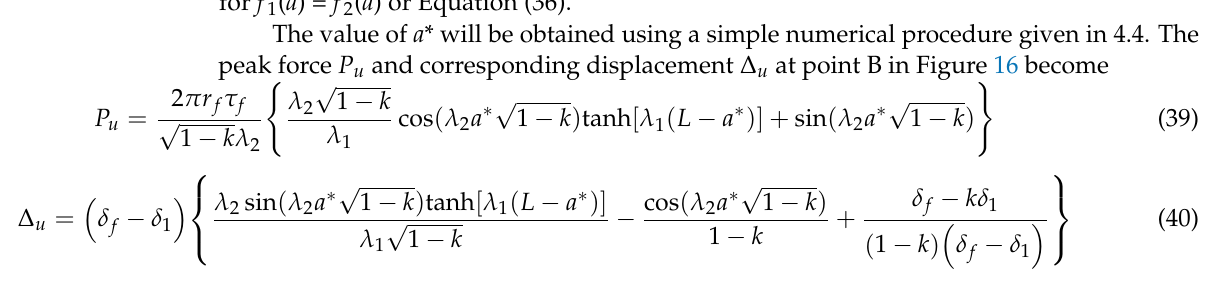
Figure 18. Function diagram for f 1 ( a ) and f 2 ( a ). The period T of f 2 ( a ) can be estimated considering the physical parameters of the materials used in the experiments. The magnitude (in the international standard unit system) of τ f , δ f − δ 1 , E f and r f is in the order of 10 6 Pa, 10 − 3 m, 10 11 Pa and 10 − 4 m, respectively, so λ 22 is in the order of 10 2 from Equation (21), that is, 1 < λ 2 < 10. Therefore, √ (cid:16) (cid:17) λ 2 T = π / 1 − k is higher than π /10 = 0.314 m, considering 0 < k < 1. The embedment length of steel fibres in this study is L = 0.04 m, which is much lower than T. This also applies to SFRC and UHPFRC materials, which rarely use steel fibres longer than 40 mm in engineering practice. Therefore, there must be only one solution a = a * in the range of (0, L ) for f 1 ( a ) = f 2 ( a ) or Equation (36).